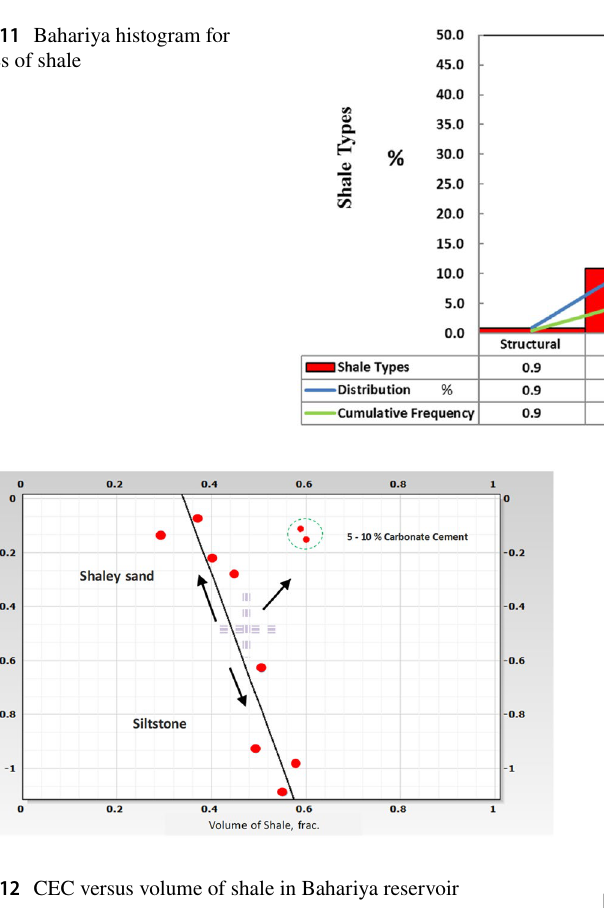
Fig. 13 CEC versus porosity of Bahariya